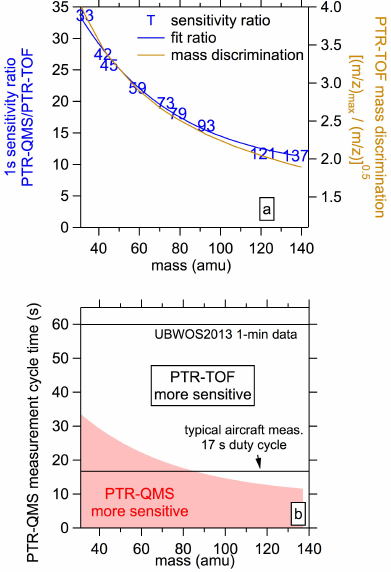
Figure 4. (a) The ratio of the 1s sensitivities of PTR-QMS / PTR- TOF together with the PTR-TOF mass discrimination. (b) A mass- dependent curve showing the length of the PTR-QMS measurement cycle, where the PTR-QMS is as sensitive as the PTR-TOF (iden- tical to the fit in a ). In aircraft measurements a duty cycle of 17s is typical (PTR-TOF more sensitive above mass 80) and at ground sites 1min measurements are typical (PTR-TOF more sensitive for all